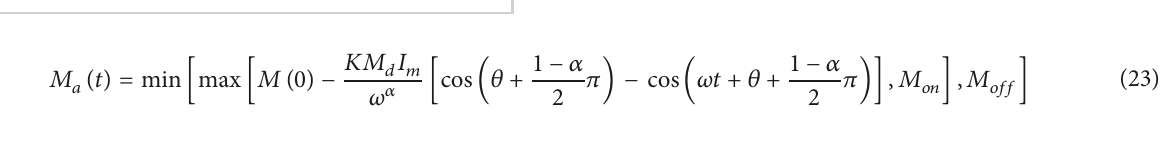
Figure 21: 𝑀(𝑡) - 𝑖(𝑡) of the fractional order memristor ( 𝐼 𝑚 < 0 ): 𝛼 = 0.75 (red), 𝛼 = 1 (green), and 𝛼 = 1.25 (blue).